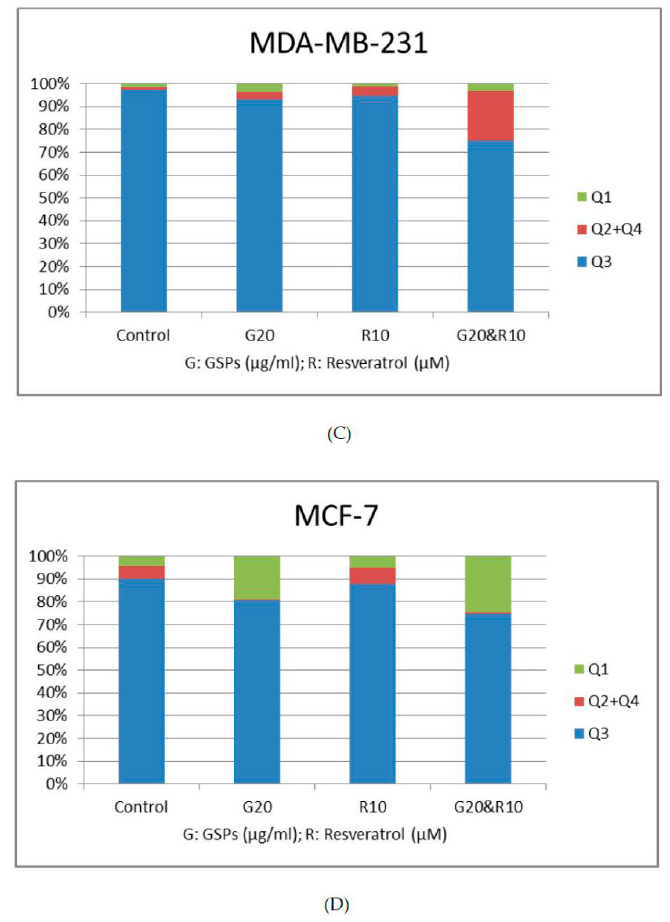
Figure 3. Apoptosis Assay. Morphological and apoptotic changes of MDA-MB-231 ( A , C ) and MCF-7 ( B , D ) human breast cancer cells induced by GSPs (20 μ g/ML), Res (10 μ M), and their